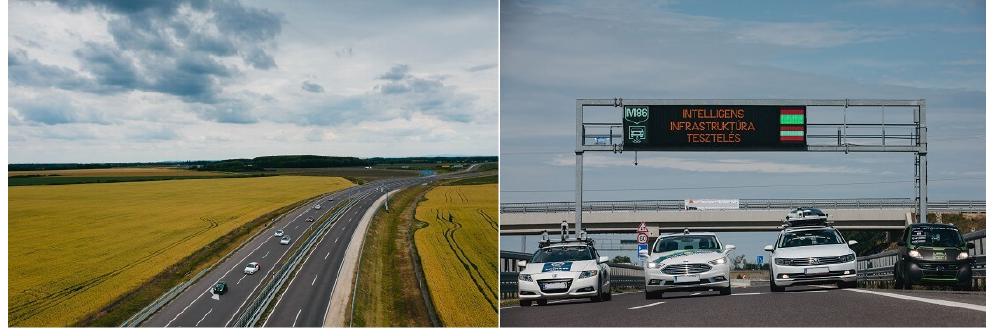
Figure 5. Austro-Hungarian Test Campaign conducted in June 2020.